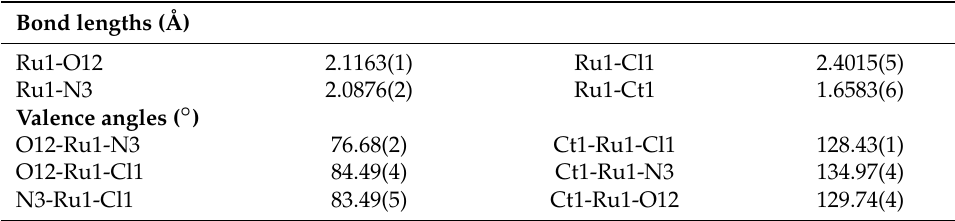
Table 2. Selected bond lengths (Å) and angles ( ◦ ) for complex 1 .